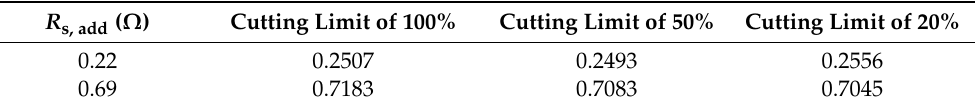
Table 6. Difference in mean R s values obtained from 1300 successive I – U curves between aged and non-aged PV modules using entire I – U curves or partial I – U curves with the cutting limits of 50% and 20% of P MPP . R s, add ( Ω